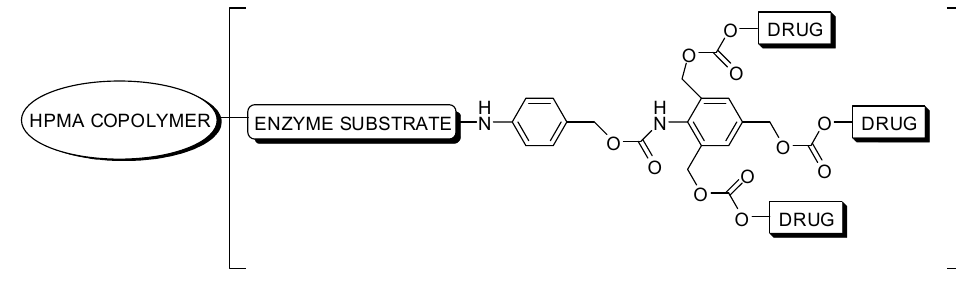
Figure 16. Dendrimer prodrug designed with PAMAM-G2.5-COOH-methotrexate [67].